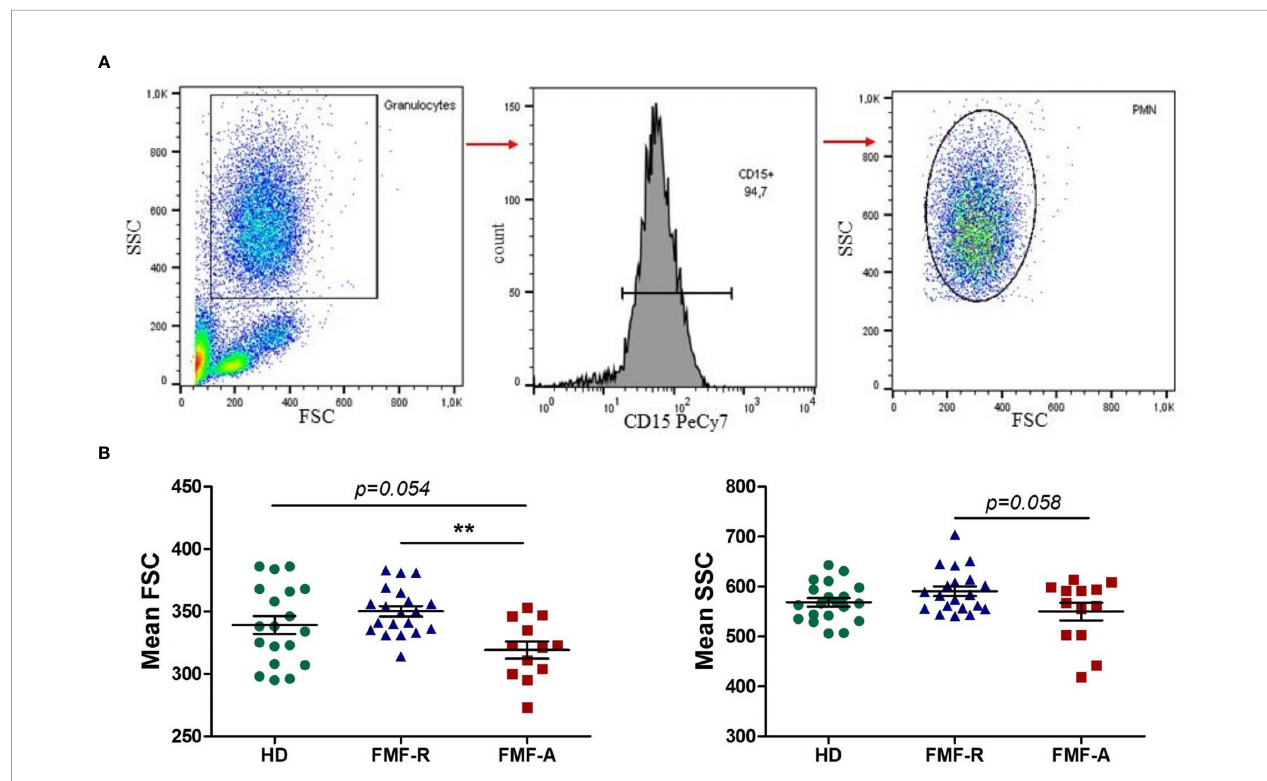
FIGURE 1 | Analysis of morphological parameters of PMN. (A) Backgating strategy for PMN identi fi cation and FSC/SSC values. (B) Mean FSC and SSC parameters values of circulating PMNs in HD, FMF-R and FMF-A groups. ** p <